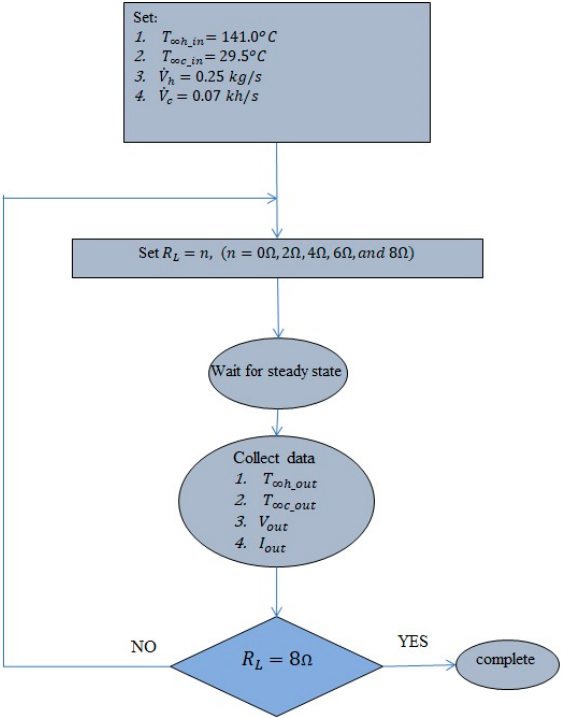
Figure 6. Flow chart of the experimental procedures.